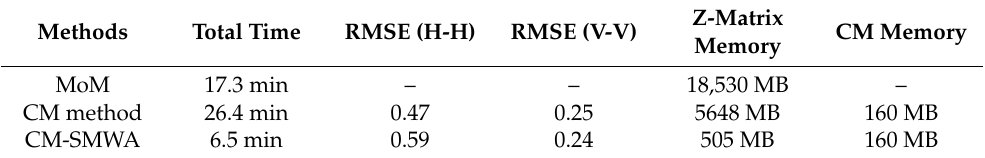
Table 4. Comparison of the CPU time and memory requirement of the different algorithms at 35 GHz.